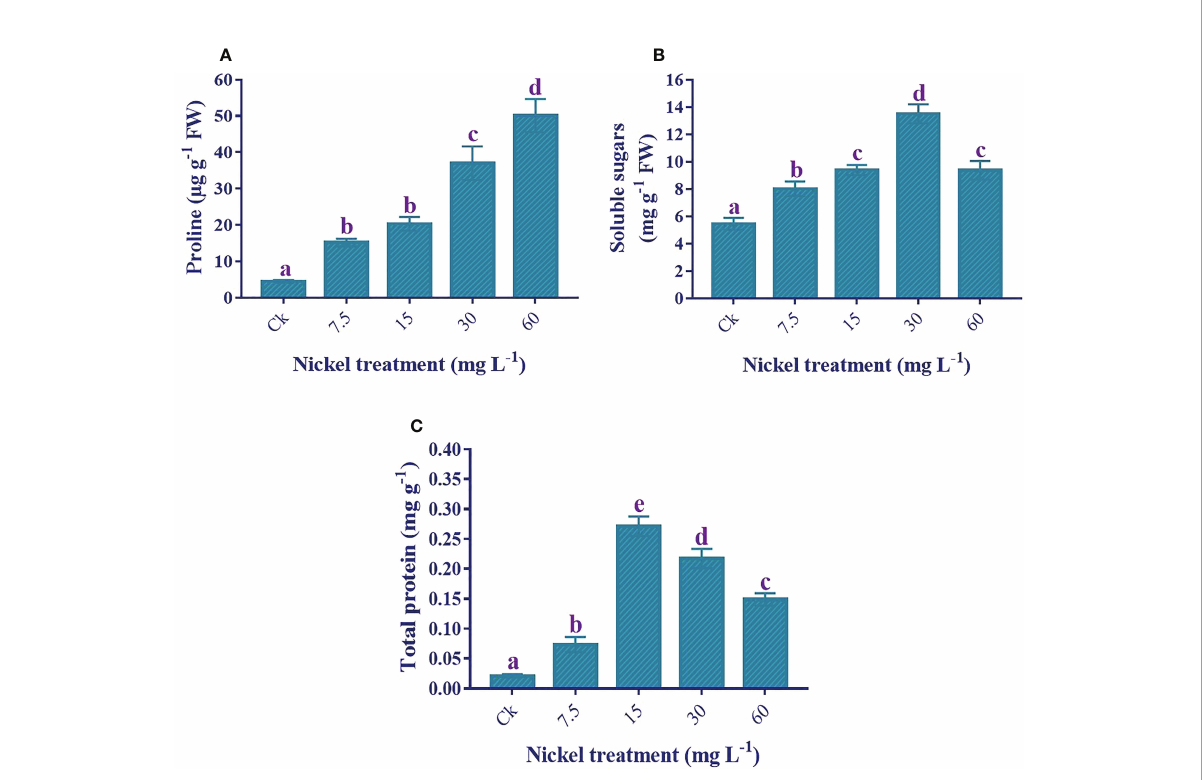
FIGURE 7 Effect of different Ni treatments on the production of osmolytes in the leaves of sweetpotato. (A) proline content, (B) soluble sugar content, and (C) total protein content. According to the Duncan test, different letters indicate a signi fi cant difference ( p < 0.05) among the fi ve treatments. The error bars represent the mean ±